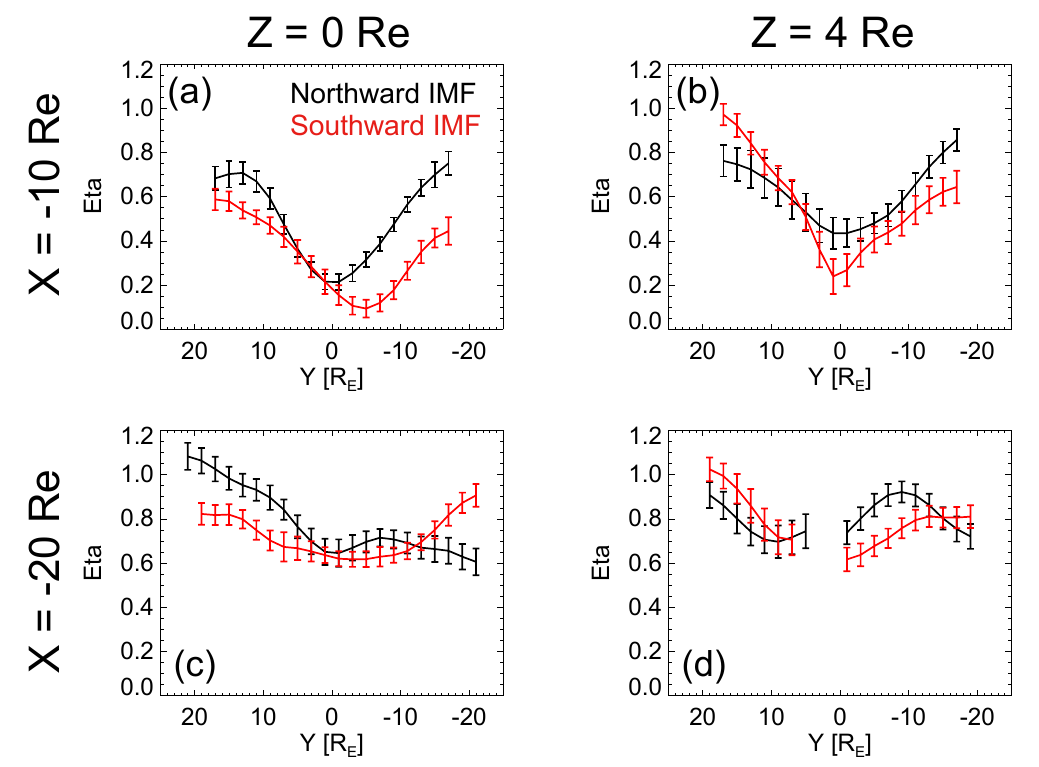
Fig. 5. Y profiles of parameter η for the northward and southward IMF conditions. Format is the same as Fig. 3. Error bar is Error bars 1- σ of least square